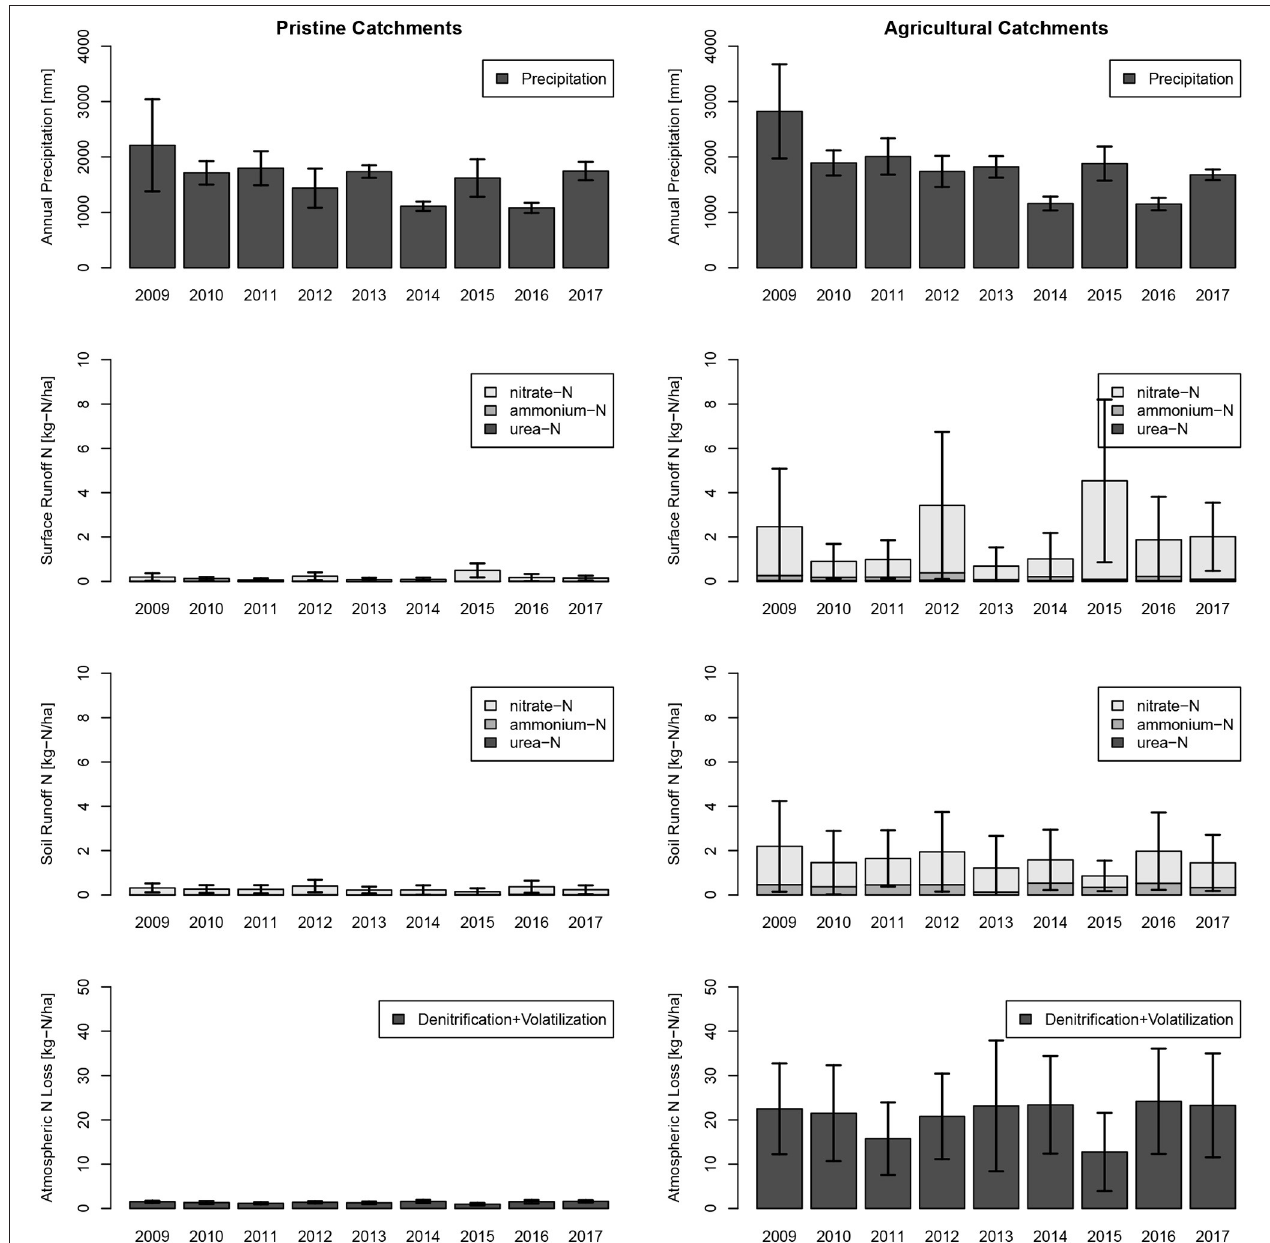
FIGURE 9 | Annual sums of precipitation and total-N contribution from urea-N, ammonium-N, and nitrate-N to creeks and standard deviations of the model results in immediate surface runoff (Surface Runoff) and retarded interflow (Soil Runoff) are indicated. Results were split into pristine (no horticulture) and horticultural catchments. The year 2017, on which the model is calibrated, shows nitrogen leakage of an average amount compared to the years